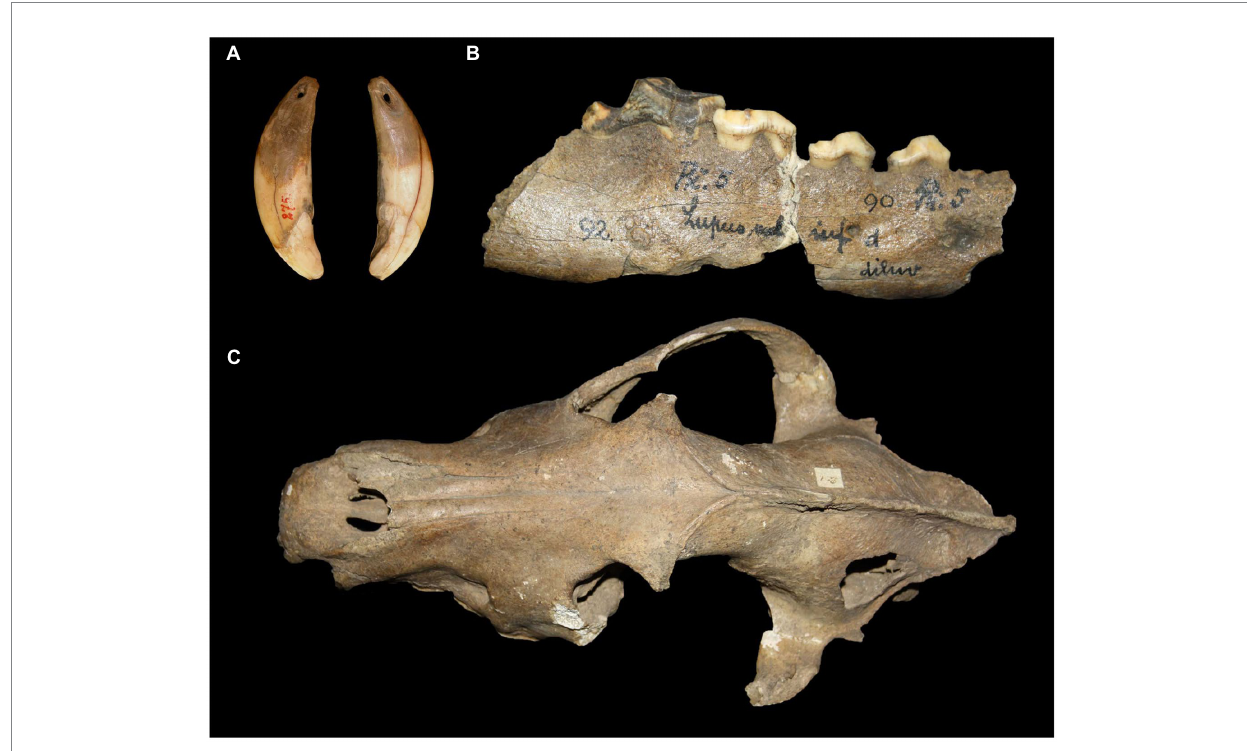
FIGURE 5 Images of Upper Paleolithic wolf remains with human modification. (A) Perforated canine from a large canid, Upper Paleolithic, Goyet cave, Belgium (Royal Belgian Institute of Natural Sciences [RBINS]; image credit: RBINS). (B) Impact marks on the ventral edge of a mandible from a Pleistocene wolf from the Gravettian Předmostí site, Czech Republic (Moravian Museum, Brno; image credit: M. Germonpré); crown length m1: 30.64 mm. (C) Dorsal view of a skull from a Pleistocene wolf from the Gravettian Předmostí site, Czech Republic, with a perforation in the left braincase (Moravian Museum, Brno; image credit: M. Germonpré); total skull length: 276.54